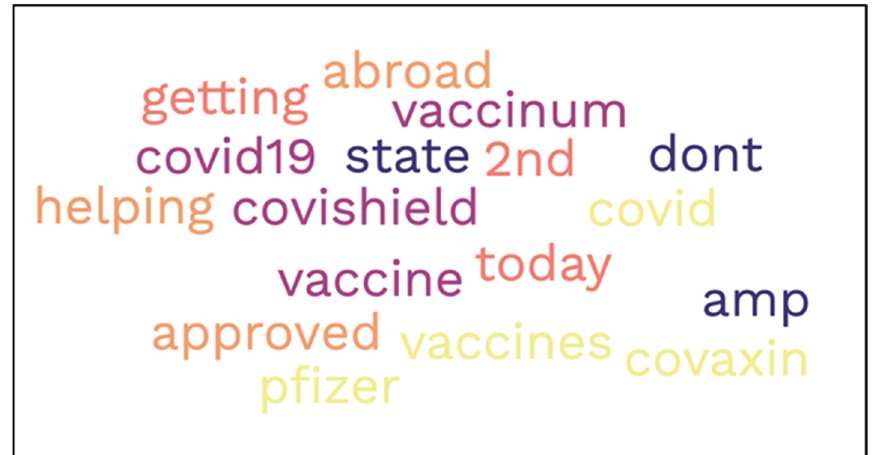
Figure 7. Word Cloud for Cluster 0 of Coronavirus tweets.